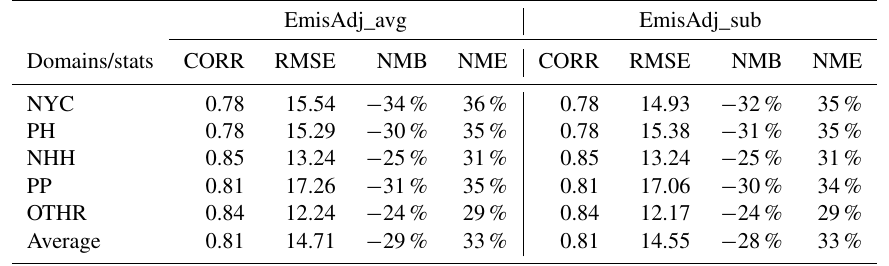
Table 4. Statistical metrics of O 3 prediction performance after NO x emission adjustment in different sub-regions from 26 to 31 August 2018.